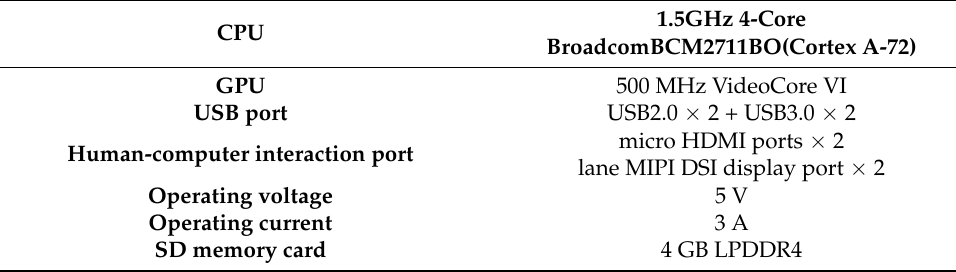
Table 2. Hardware parameters of the Raspberry Pi 4B